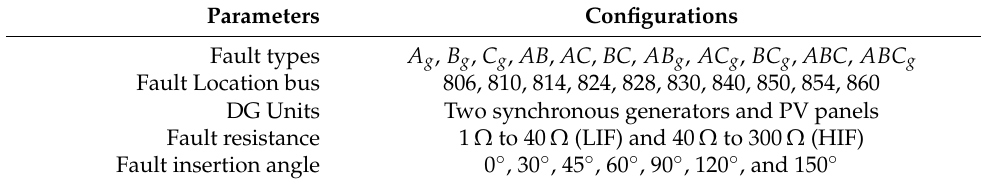
Table 5. IEEE-34 bus test system parameters for fault simulations.